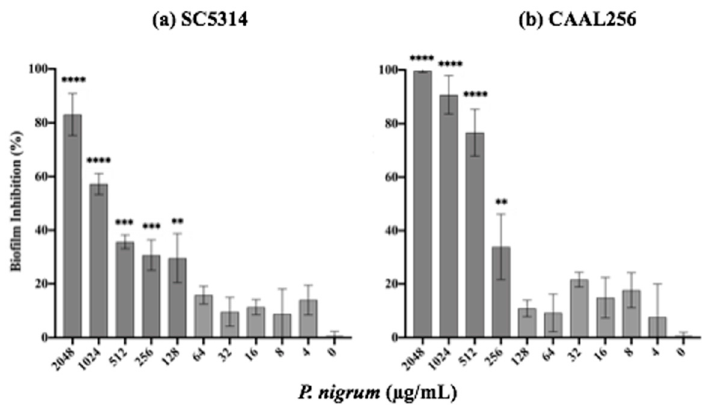
Figure 5. In vitro characterization of the inhibitory activity of P. nigrum ethanolic extract on C . albicans biofilm formation p -values of <0.05 were used to indicate statistical significance as follows: ** p ≤ 0.01. *** p ≤ 0.001. **** p ≤ 0.0001.